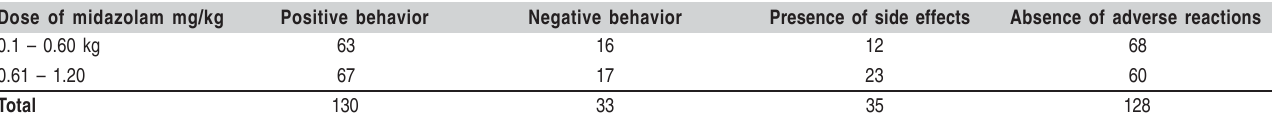
Table 2 - Distribution of behavior and side effects of subjects according to the dose of midazolam (mg/kg) during dental